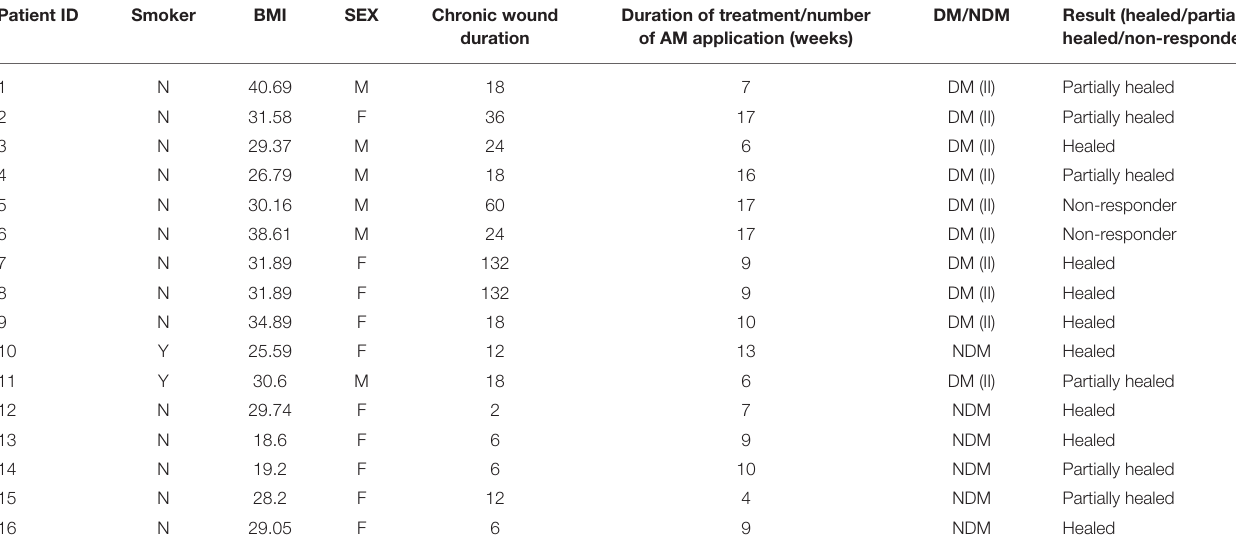
TABLE 4 | Characteristics of the patients enrolled in the study: smoker and body mass index (BMI). Patient ID Smoker BMI SEX Chronic wound